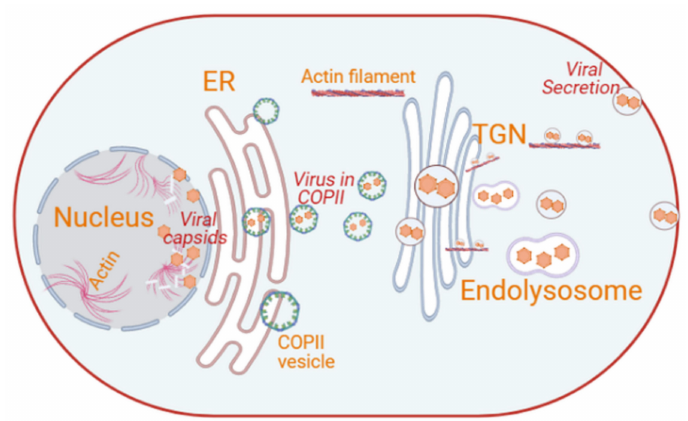
Figure 6. Intracellular membrane rearrangements induced by parvoviruses. Parvoviruses replicate and assemble their capsid in the nucleus. The nucleocapsid is transported from the nuclear periphery to the plasma membrane in a gelsolin-dependent manner. Cytoplasmic parvoviral particles are engulfed in COPII-coated vesicles at the ER, following its traffic to the Golgi. Matured virus particles are then transported to the plasma membrane possibly via the secretory pathway and actin filaments through gelsolin and are then released by activation or modulation of the PDK1/PKC/PKB signaling cascade (image created in